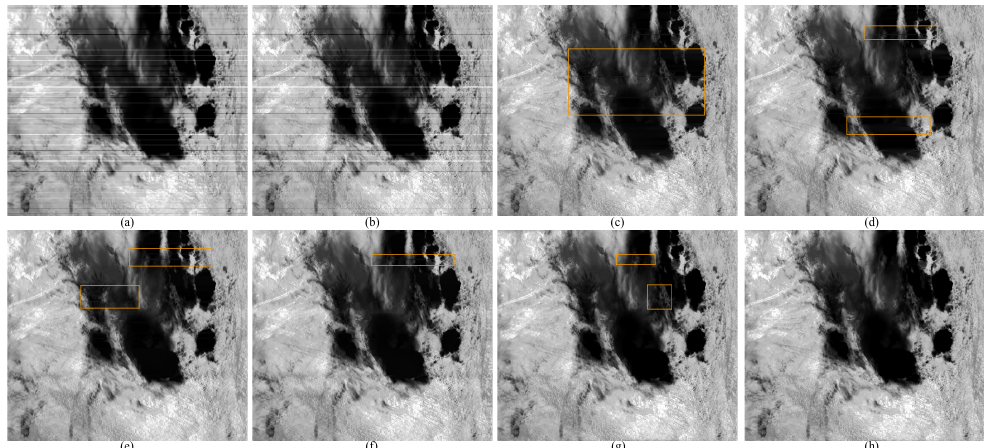
Figure 7. Results of different methods for simulated stripe MODIS data S1. ( a ) BM3D; ( b ) SNRCNN;